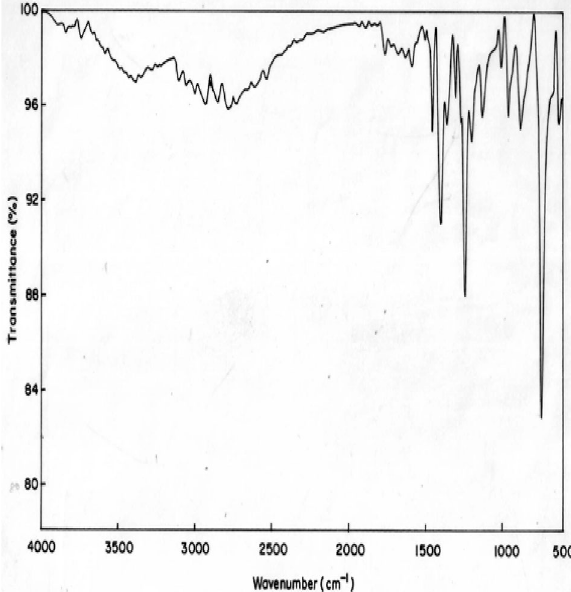
Fig. 5 Experimental FTIR spectra of curcumin